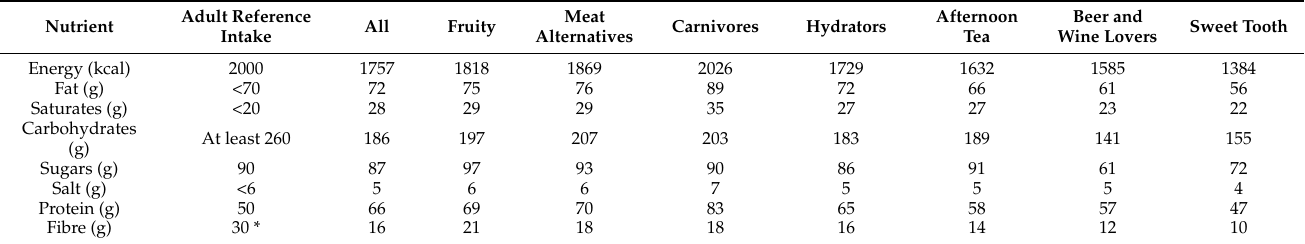
Table 1. Daily nutritional values for loyalty card holder by group. * Fibre not included in adult reference intake values, but UK recommended intake included